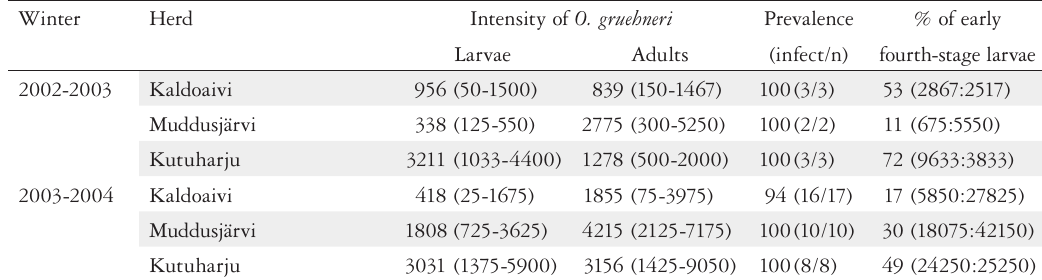
Table 4. Infection of Ostertagia gruehneri in adult reindeer. Mean intensity (range in parenthesis), prevalence (% infected), and percentage of nematodes found in the early fourth-stage of larval development (number of larvae and adults in parenthesis) of the abomasum (liquid contents and digested